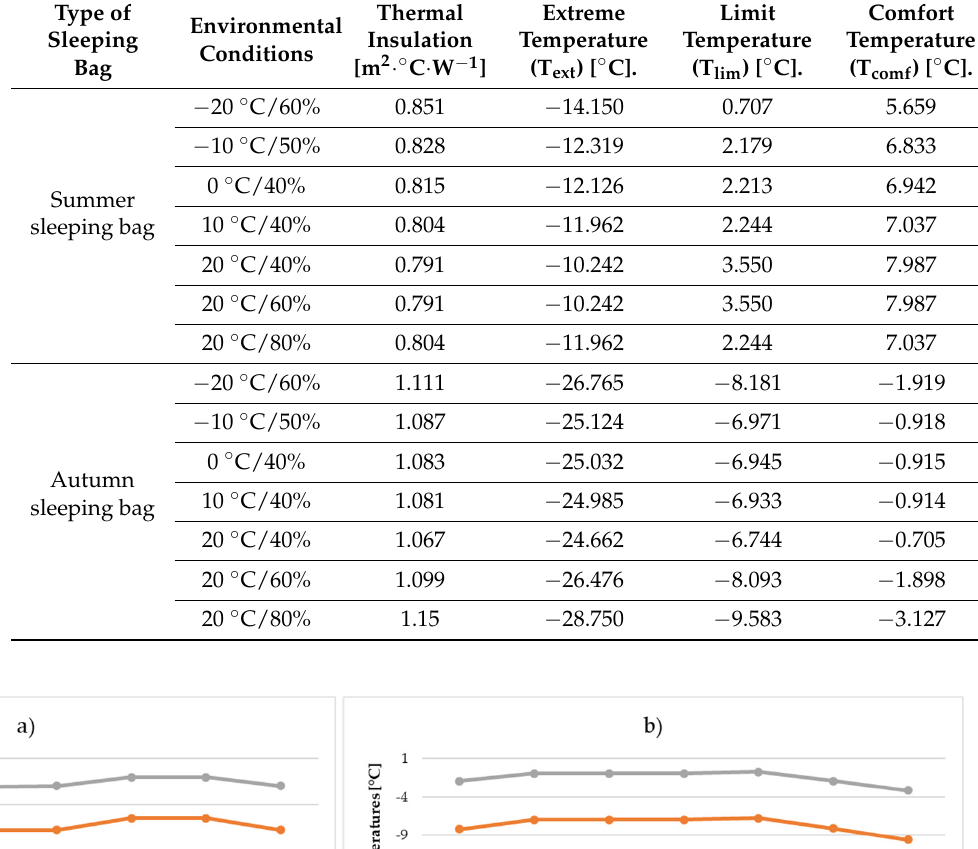
Table 11. Lower temperature limits in the range of utility.